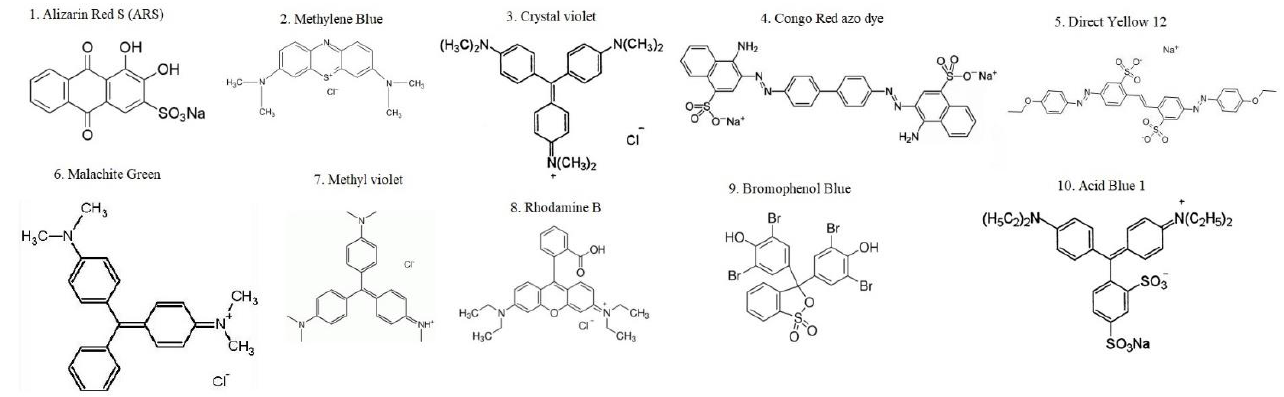
Figure 8. Chemical structures of dyes in textile wastewater.